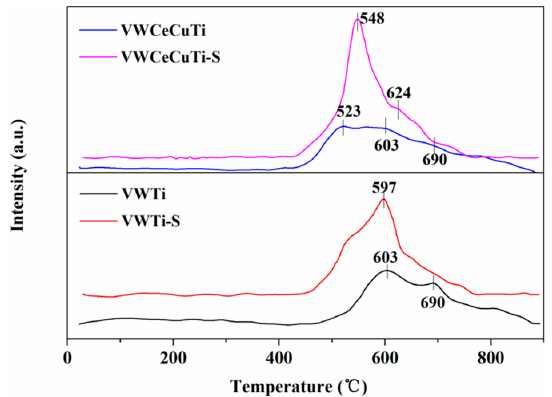
Figure 5. H 2 -TPR profiles of fresh and S-poisoned samples.